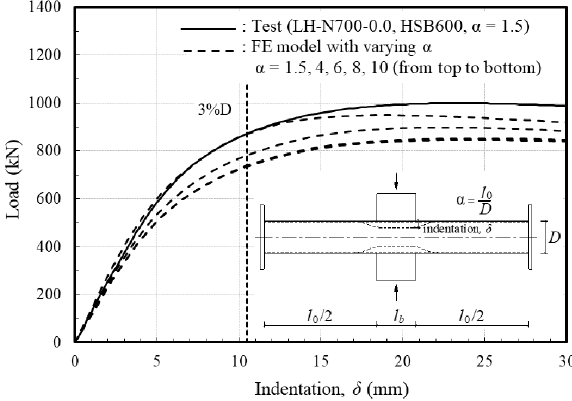
Figure 5. Chord length effect on the joint strength.